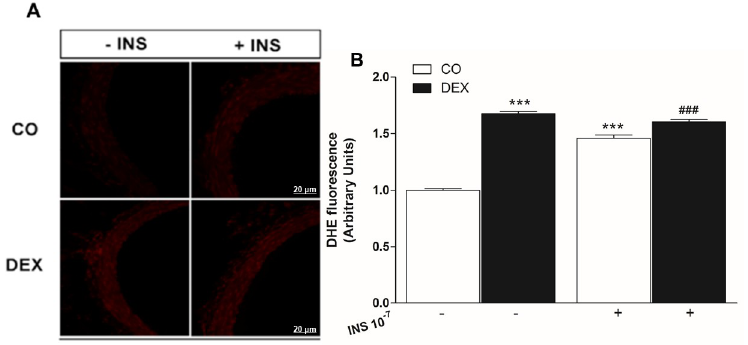
Fig 5. Effects of insulin on superoxide anion (O2•-) production in the superior mesenteric artery. (A) Representative images of DHE fluorescence, a ROS indicator and (B), quantification of DHE fluorescence in a superior mesenteric artery of control (CO) and dexamethasone treated (DEX) rats in the absence and presence of insulin. n = 10 superior mesenteric rings analyzed from 4 animals. Scale bar = 20 μ m. Values are expressed as mean ± S.E.M. For data analysis, one-way ANOVA followed by Bonferroni post-test was used. ��� p < 0.001, vs CO under basal condition (-); ###p < 0.001 vs CO under INS stimulation (+).